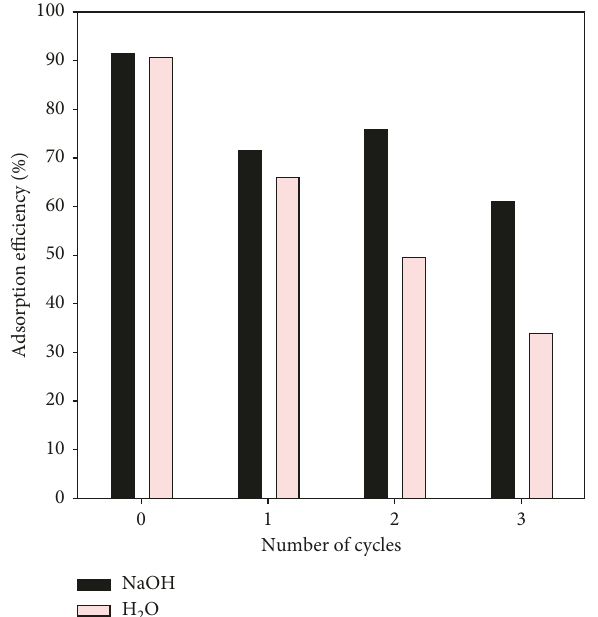
Figure 10: Regeneration and recyclability tests for the adsorption of MB.